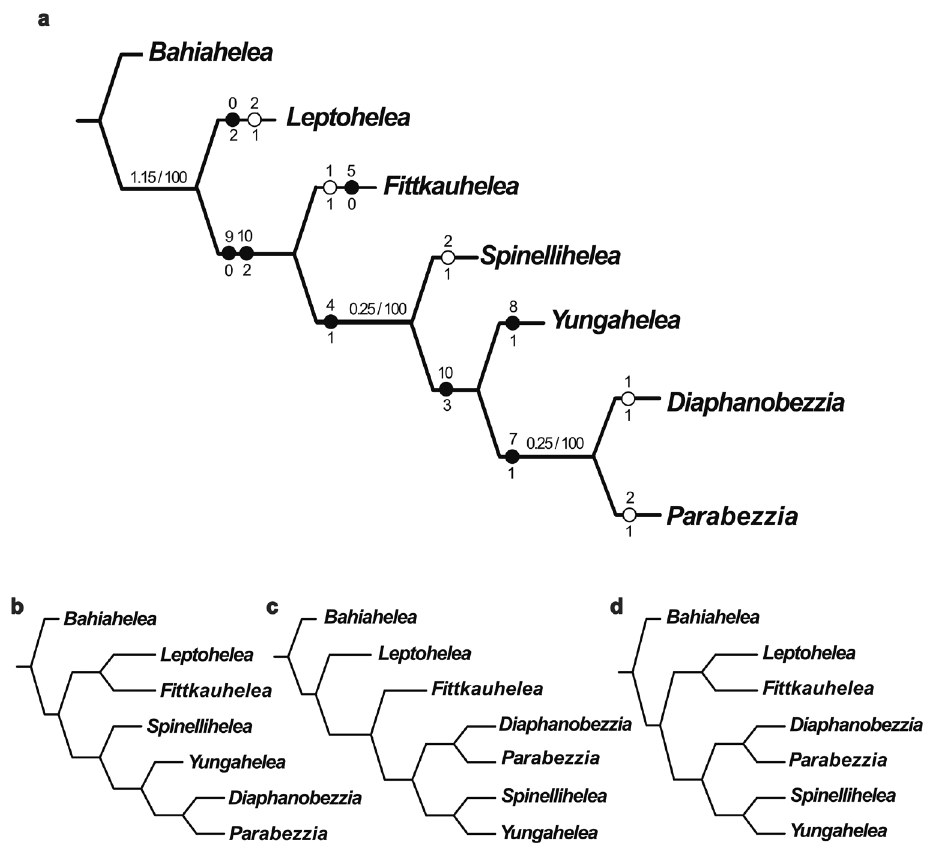
Figure 24. (a-d) cladograms obtained under K=3. The numbers above the nodes in cladogram a represent the absolute and relative Bremer supports,